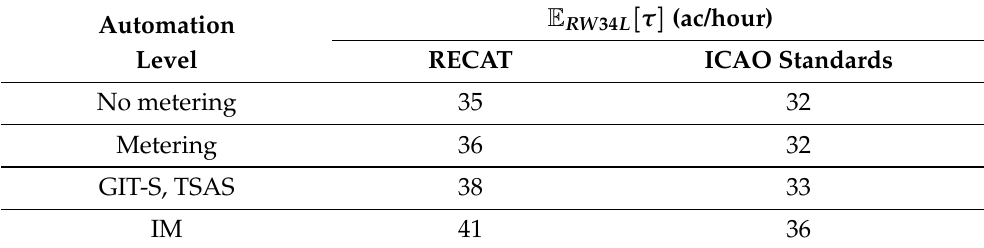
Figure 10. Estimation of the available runway capacity. Table 7. Available runway capacity under the ROT